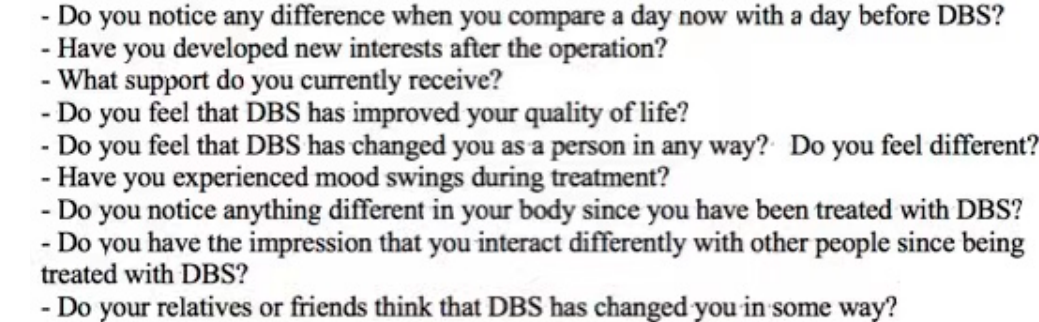
Figure A1. Extract of the interview guide.